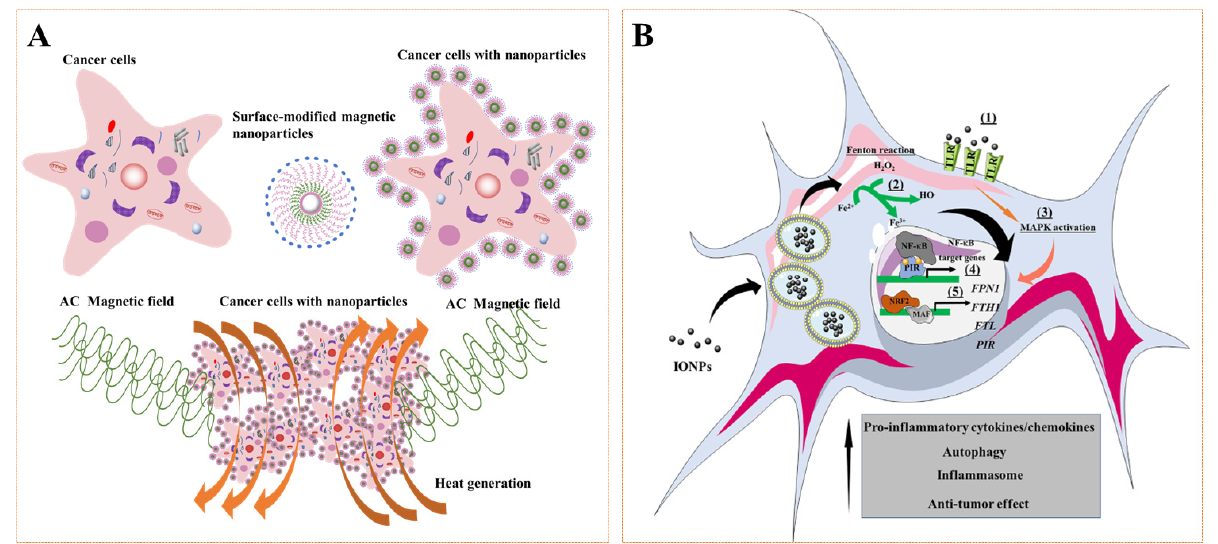
Figure 7. ( A ) General procedure for magnetic hyperthermia of tumor cells. AC: alternating current. ( B ) Overview of the effects of iron oxide nanoparticles (IONPs) on macrophage polarization. Reprinted with permission from Ref. [168]. Copyright 2017, copyright Mulens-Arias V. et al.